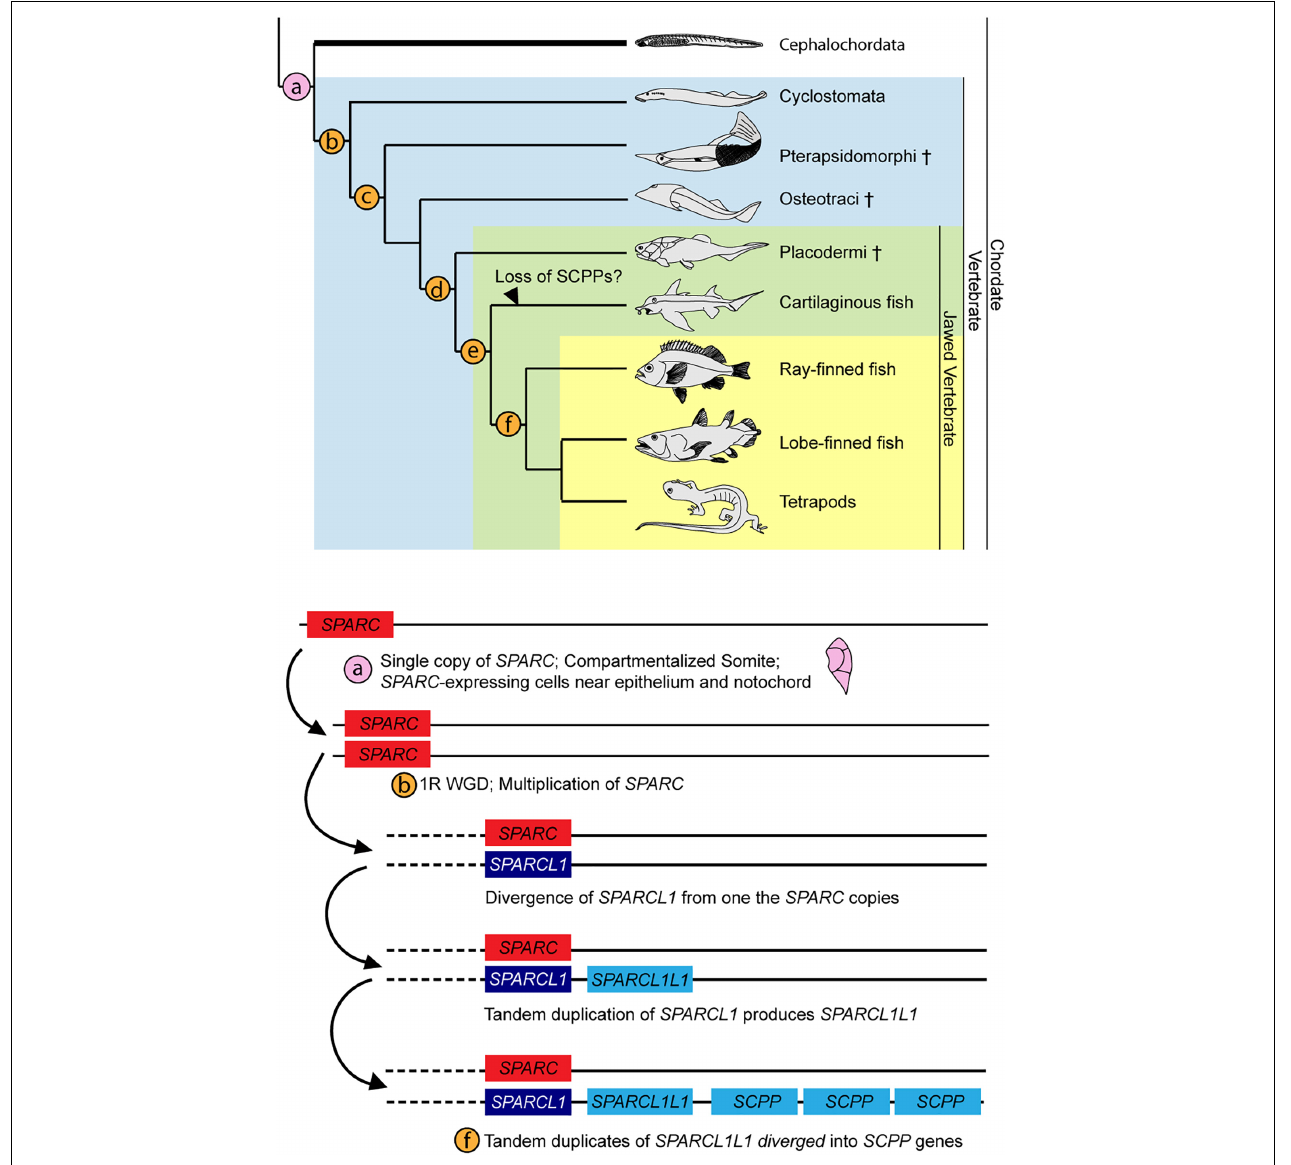
FIGURE 8 | Summary of SPARC family expansion throughout chordate phylum. Cross indicates extinct taxa. Phylogenetic tree is adapted from Kawasaki and Weiss (2006). Expansion of SPARC family is adapted from Kawasaki and Weiss (2006), with updates from findings in Kawasaki (2018). (a) Somite compartmentalization is present in the common ancestor of all chordates. Mesoderm-derived rudimentary collagenous skeleton ensheaths the outer layer of the somite and the notochord. Cartilaginous tissues are found in the oral cirri (cellular) and pharyngeal region (acellular) (Rychel et al., 2005; Jandzik et al., 2015). (b) 1R of whole genome duplication. Sparca and Sparcb in lamprey co-orthologs of Sparc (Bertrand et al., 2013; Kawasaki, 2018; Simakov et al., 2020). (c) All four types of skeletal tissue (cartilage, bone, dentine, enameloid) found (Keating et al., 2018). (d) 2R of whole genome duplication (Simakov et al., 2020). (e) SPARCL1L1 ( SPARCL2 in Enault et al., 2018) in chondrichtyhans is likely originated from an asymmetric duplication of Sparcb (Kawasaki et al., 2017; Kawasaki, 2018). (f) SPARCL1L1 tandem duplicates, subsequent copies diverged into the SCPP gene family (Kawasaki et al., 2017; Kawasaki,